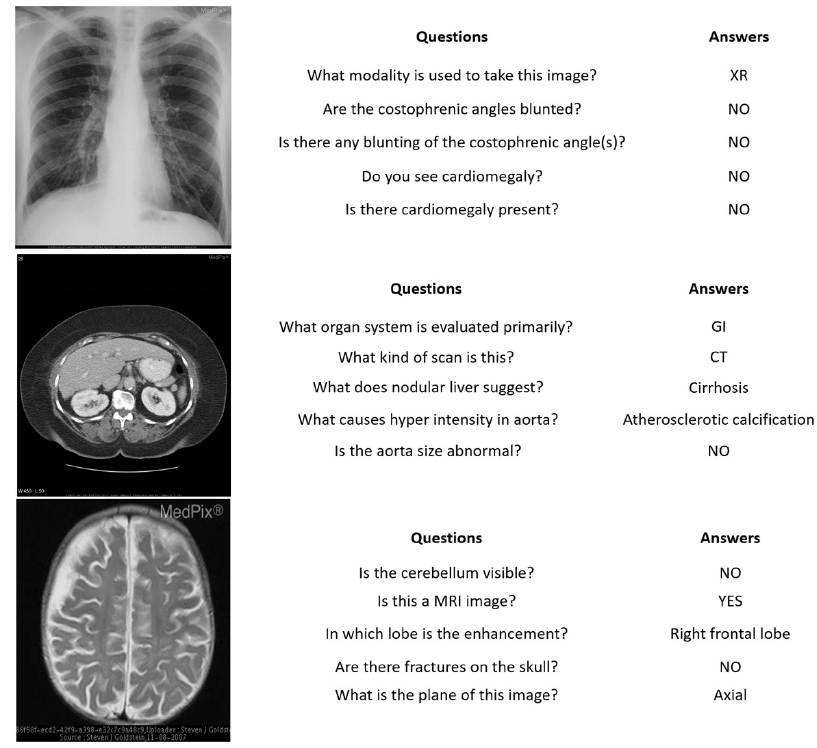
Figure 5. VQA ‐ RAD images, questions, and answers. Figure 5. VQA-RAD images, questions, and